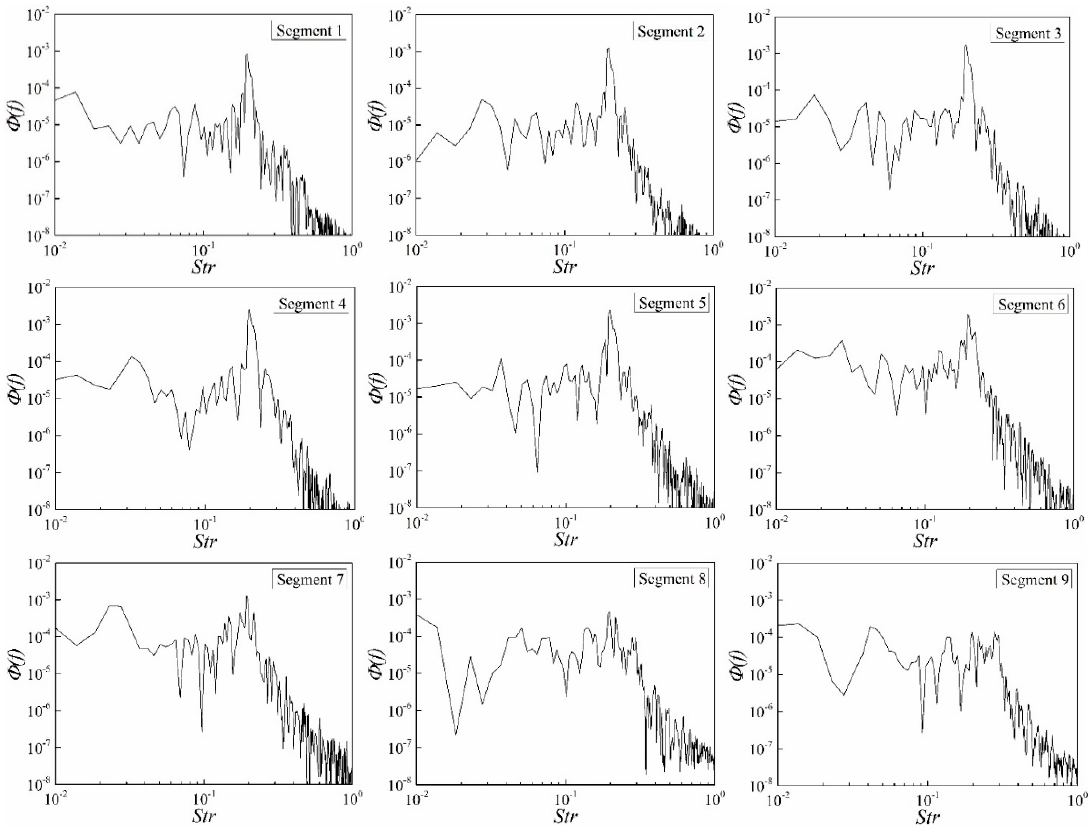
Figure 14. Power spectra of segmental lift coefficient at yaw angle of 15 ° .